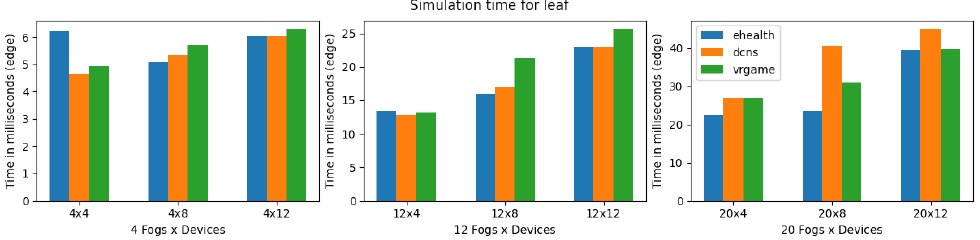
Figure 13. Execution time for